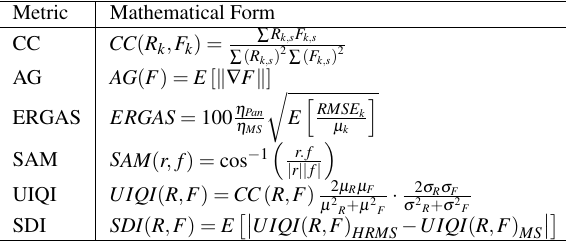
Table 2: Quantitative image fusion performance metrics Metric Mathematical Form